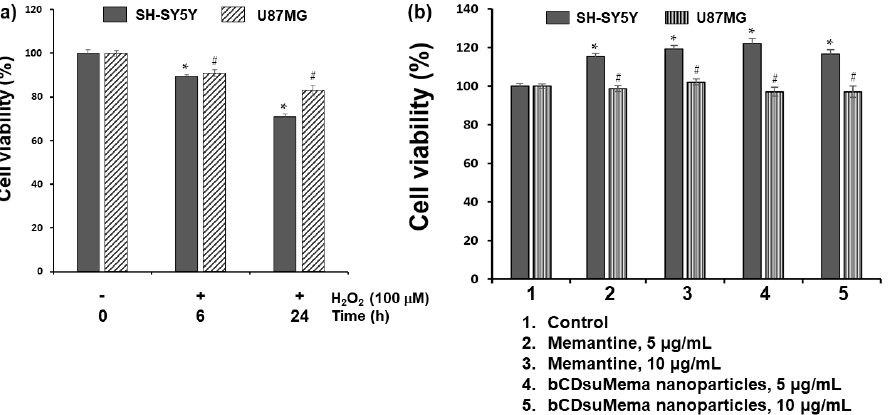
Figure 6. ( a ) The effect of H 2 O 2 on the viability of cells. ( b ) The effect of memantine and